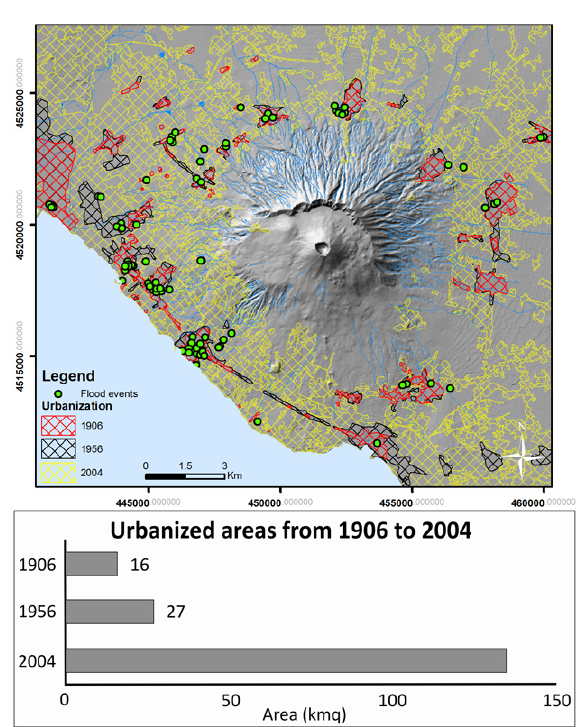
Figure 15. Time evolution of the urbanized areas of the Somma- Vesuvius district from 1906 to